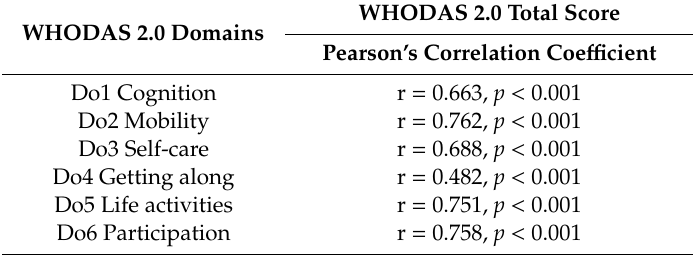
Table 3. Internal Structure of the 36-item WHODAS 2.0 for patients with